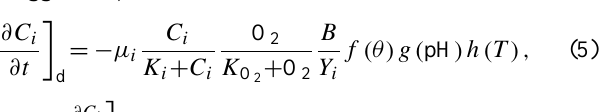
the fraction of carbon released in the monomers, and x j are the stoichiometric coefficients in Eq. (2) for each monomer.